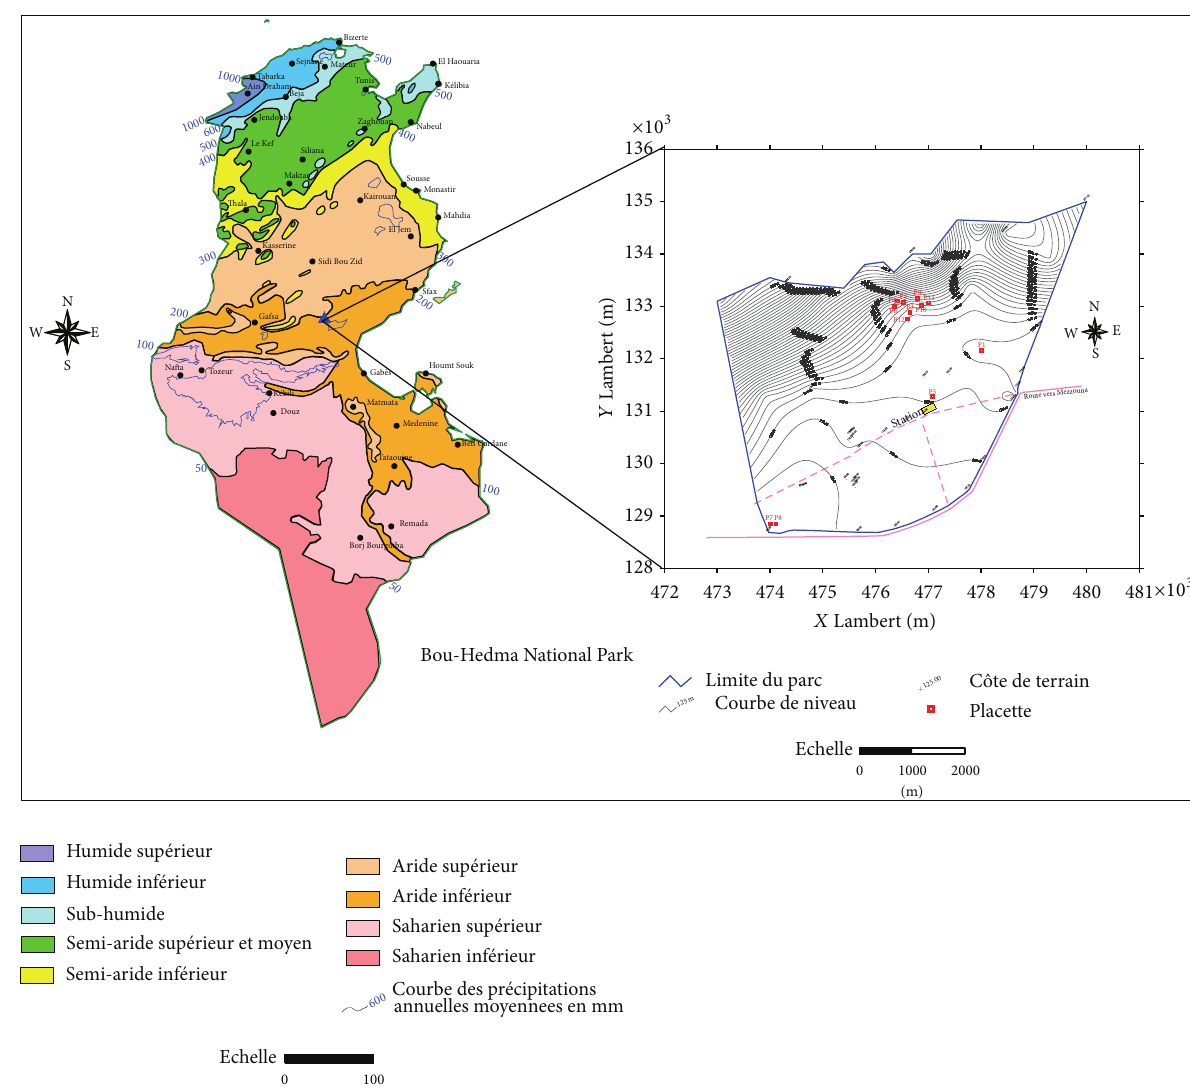
Figure 1: Location of the Bou-Hedma National Park in the bioclimatic map of Tunisia